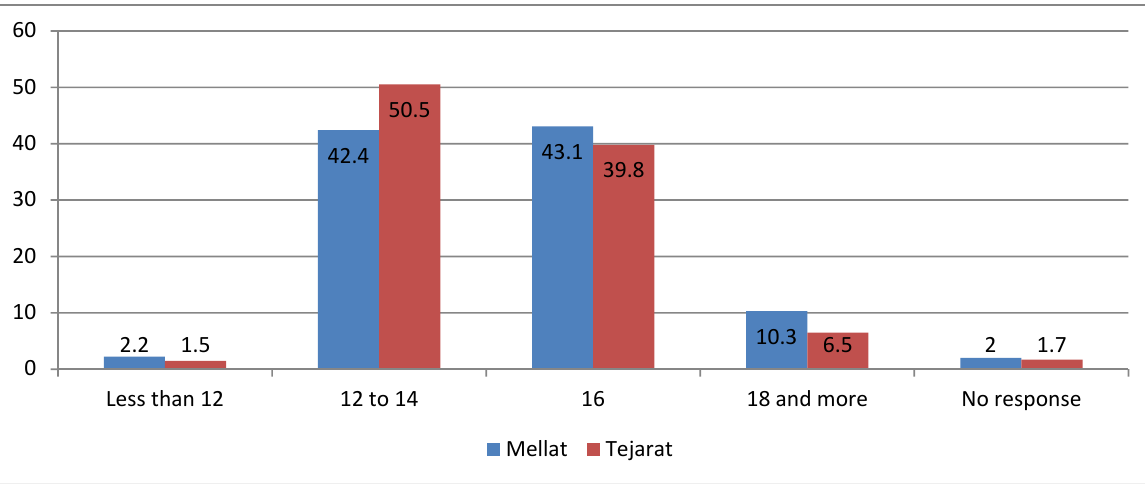
Fig. 2. Frequency of participants’ educational backgrounds